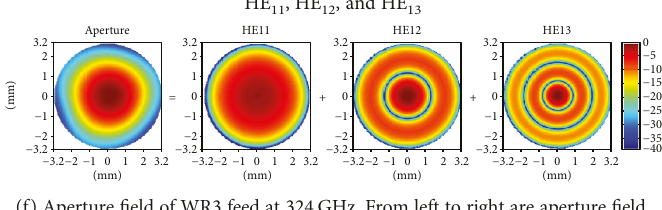
Figure 3: The radiation far- fi eld and aperture patterns of corrugated feed